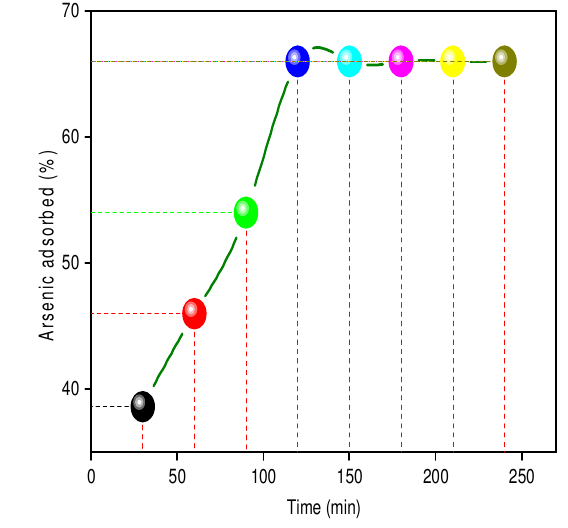
Fig. 5: Mixing Time Effect on As(III) Adsorption (Adsorbent 0.5g per 50ml, As(III) Concentration 50 ppb, ph 6, RPM 150).